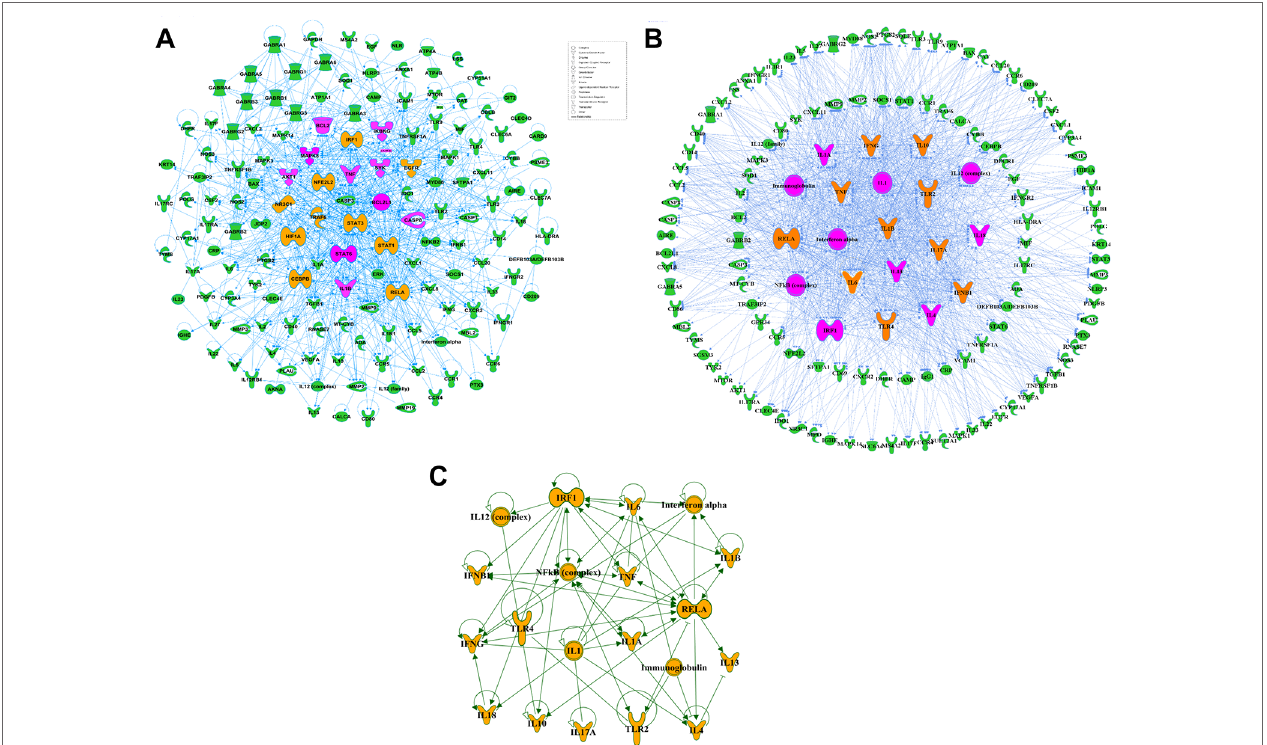
FIGURE 1 | Target proteins related to fungal infection were identified in network pharmacology analysis. (a) Protein-protein interactions of the potential and proved therapeutic targets in fungal infection. The top ten targets predicted by IPA were marked in saffron yellow and the top 20 molecules were labeled with purple-red. (B) Top 20 upstream regulators of the potential and proved therapeutic targets in fungal infection and their relationships with the related targets. The top ten upstream regulators predicted by IPA were marked in saffron yellow and the top 20 targets were marked in purple-red. (C) The network among top 20 upstream regulators of the potential and proved therapeutic targets in fungal infection predicted by